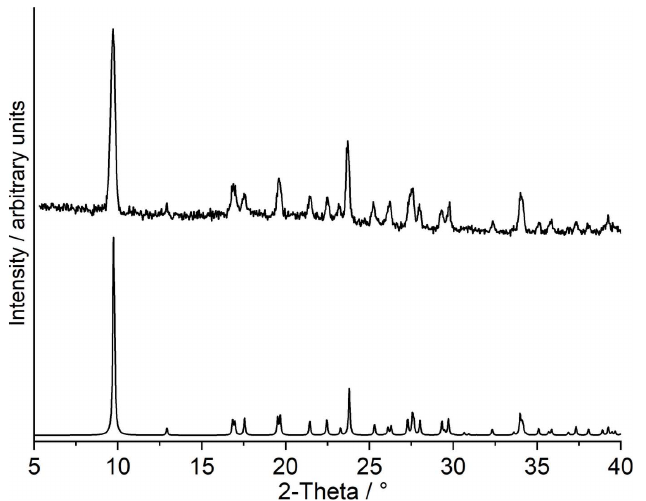
Figure 4 Experimental PXRD pattern of the residue obtained after the first mass loss in a DTA–TG–MS measurement of the title compound (top) and PXRD pattern calculated for CuI(2-chloropyrazine)